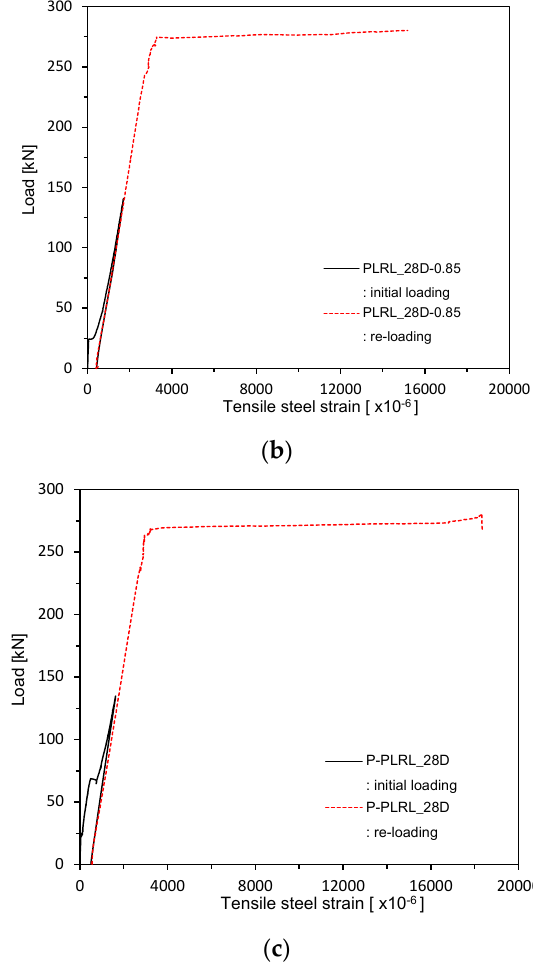
Figure 15. Load–steel reinforcement strain measurement after 28 days (up to ultimate load after pre-loading): ( a ) 2.5 series; ( b ) 0.85 series; ( c ) Plain series.